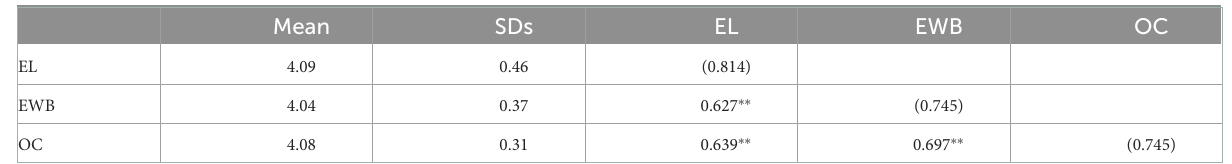
TABLE 1 Correlation